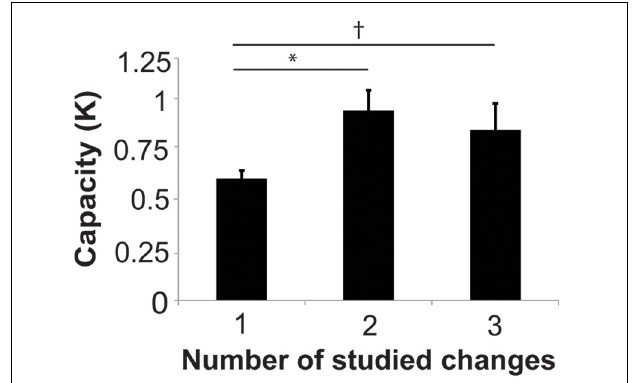
FIGURE 2 | Capacity (K) for remembered changes in studied images (1, 2, or 3-change conditions). ∗ Indicates p < 0 . 05, Holm-Bonferroni corrected. † Indicates p < 0 .